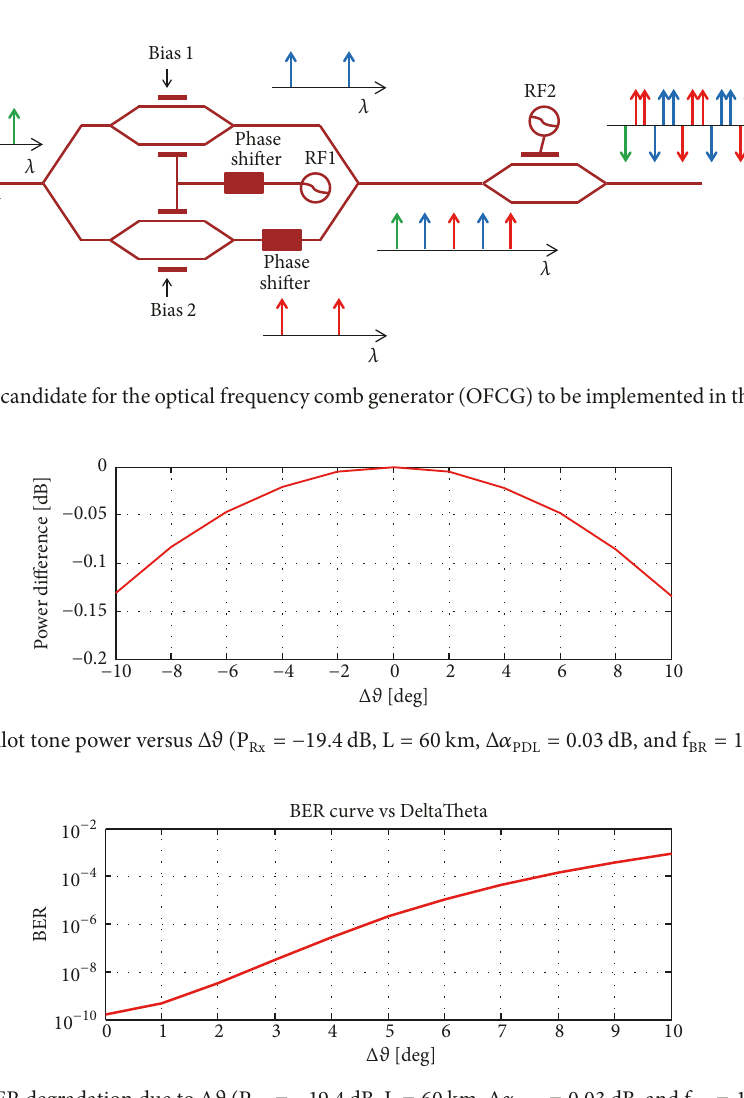
Figure 13: BER degradation due to (cid:2) 𝜗 (P Rx = −19.4 dB, L = 60 km, (cid:2) 𝛼 PDL = 0.03 dB, and f BR = 10 Gbit / s ) .